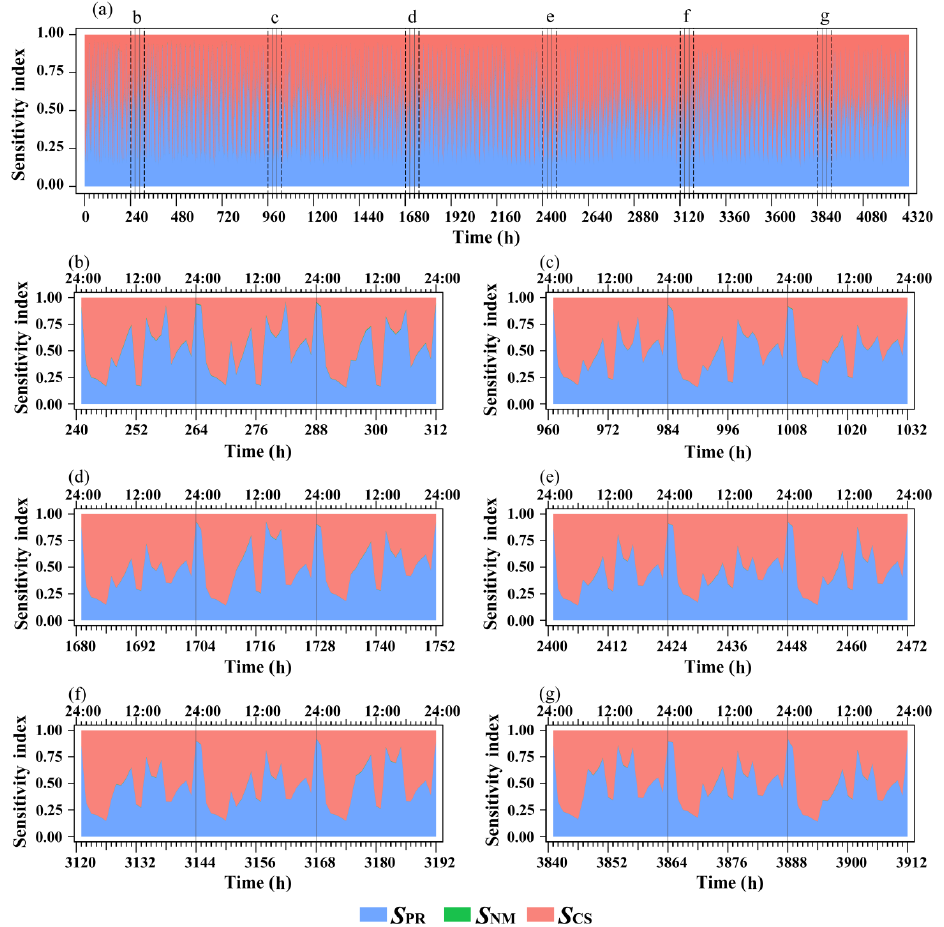
Figure 5. Estimated sensitivities for the spatially averaged evapotranspiration (ET) at whole time steps (a) . We chose six periods at 3d intervals to display the sensitivity index values in detail. The bottom six figures exhibit the sensitivity index results for 241–312h (b) , 961– 1032h (c) , 1681–1752h (d) , 2401–2472h (e) , 3121–3192h (f) , and 3841–3912h (g) . S PR is the sensitivity index for parameters. S NM is the sensitivity index for models and represents the influence of aquifer thickness. The S CS is the sensitivity index for climate scenarios. The bottom x axis of (b–g) represents the simulated time steps, and the upper x axis of (b–g) represents the local